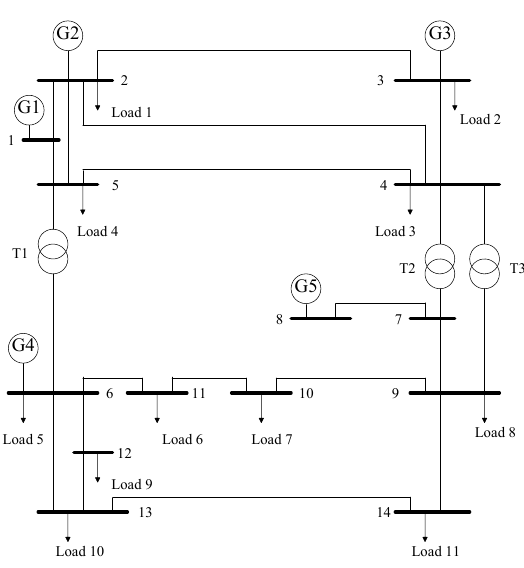
Figure 6. IEEE 14-bus system: 14 buses, 5 generators, and 11 loads ( n = 14, m = 11). Table 2. Parameter Settings.